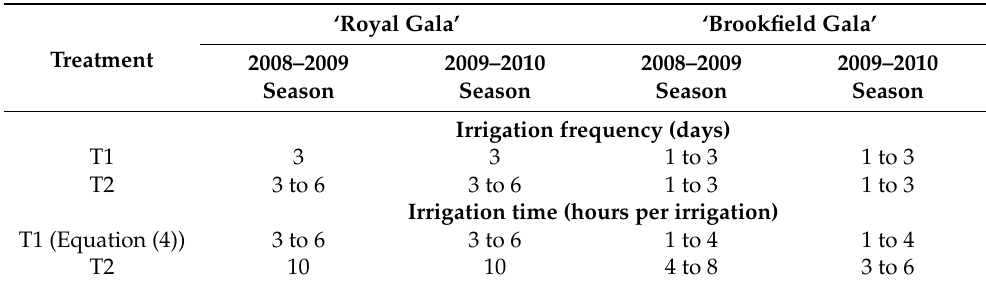
Table 2. Irrigation characteristics in commercial orchards of ‘Royal Gala’ and ‘Brookfield Gala’ apple trees in the 2008–2009 and 2009–2010 seasons. ‘Royal Gala’ ‘Brookfield Treatment